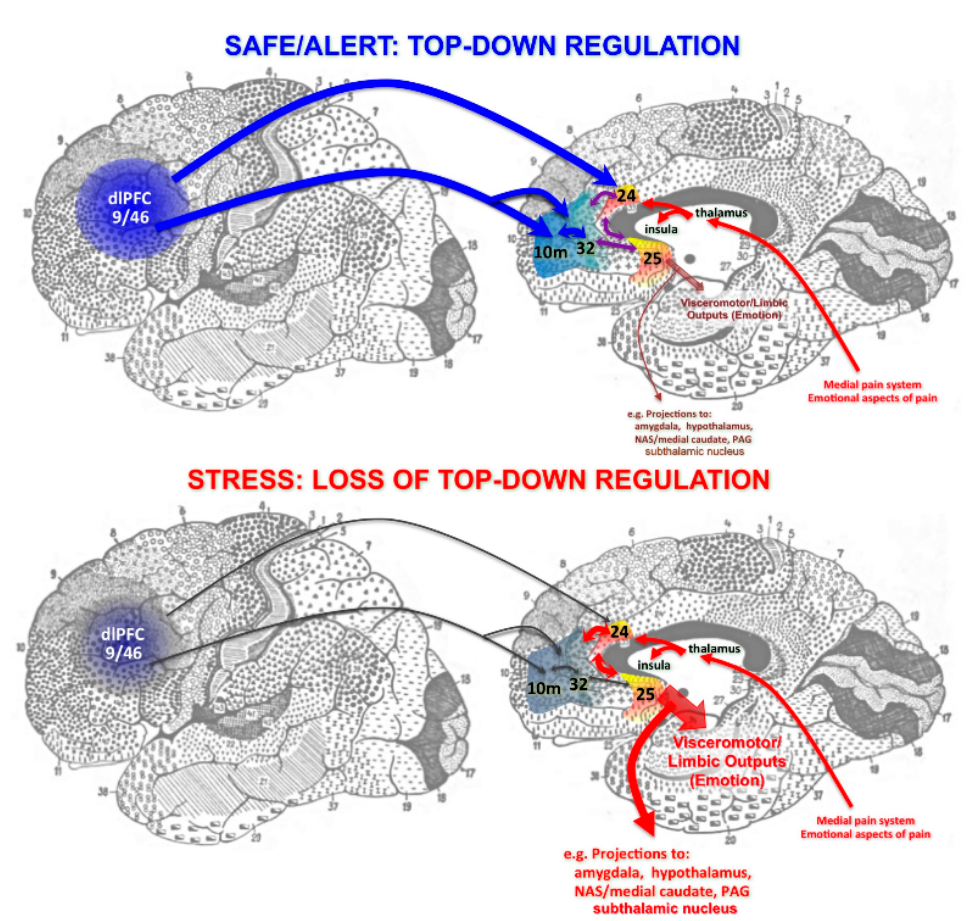
Figure 1. Schematic diagram of prefrontal cortex (PFC) circuits providing top-down regulation of emotion, and the e ff ects of arousal state on connectivity. ( Top ): Under non-stress conditions, newly evolved dorsolateral PFC (dlPFC) and rostral areas (e.g., BA10) project back to anterior (BA24) and subgenual (BA25) cingulate via BA32 to regulate visceromotor output and emotional response. Note that these cingulate areas are part of the pathway that mediates the emotional aspects of the pain response. ( Bottom ): Under conditions of uncontrollable stress, the connectivity of dlPFC and the rostral aspect of medial PFC are weakened, and the top- down suppression of BA25 is diminished, promoting activation of subcortical structures such as the amygdala. Anatomical projections are based on tracing studies in monkeys [38], but are portrayed on a Brodmann drawing of the human brain to facilitate translation to human brain imaging results.